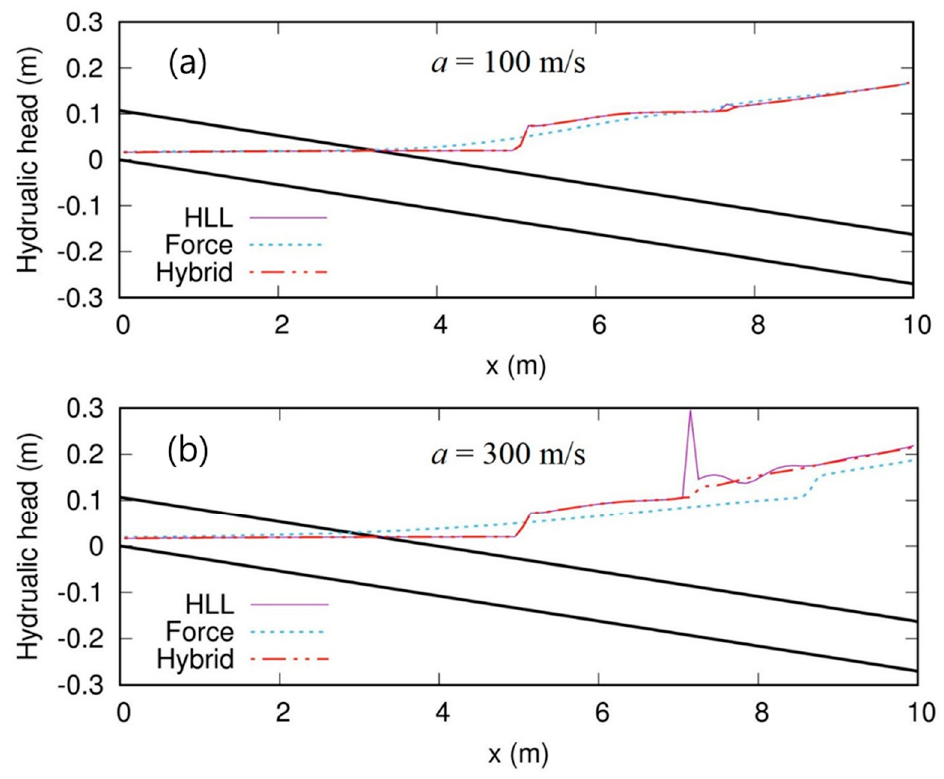
Figure 6. Hydraulic-head profiles simulated by different flux schemes at 30 s (Test 3). The two black lines represent the location of the sewer pipe with ( a ) a = 100 m/s; ( b ) a = 300 m/s.